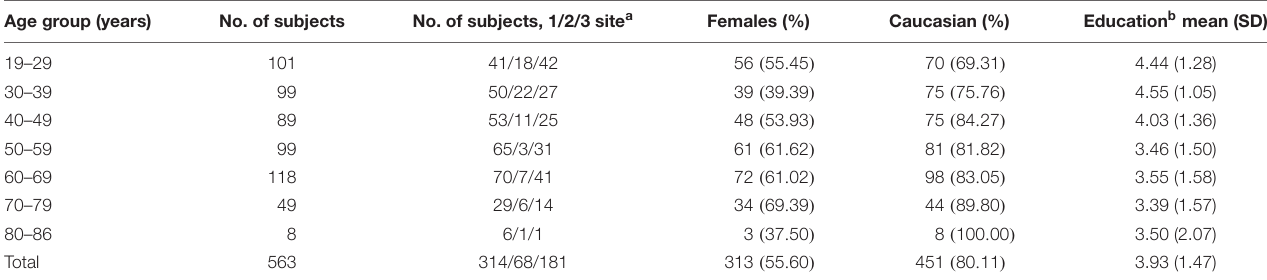
TABLE 1 | Sample characteristics in different age